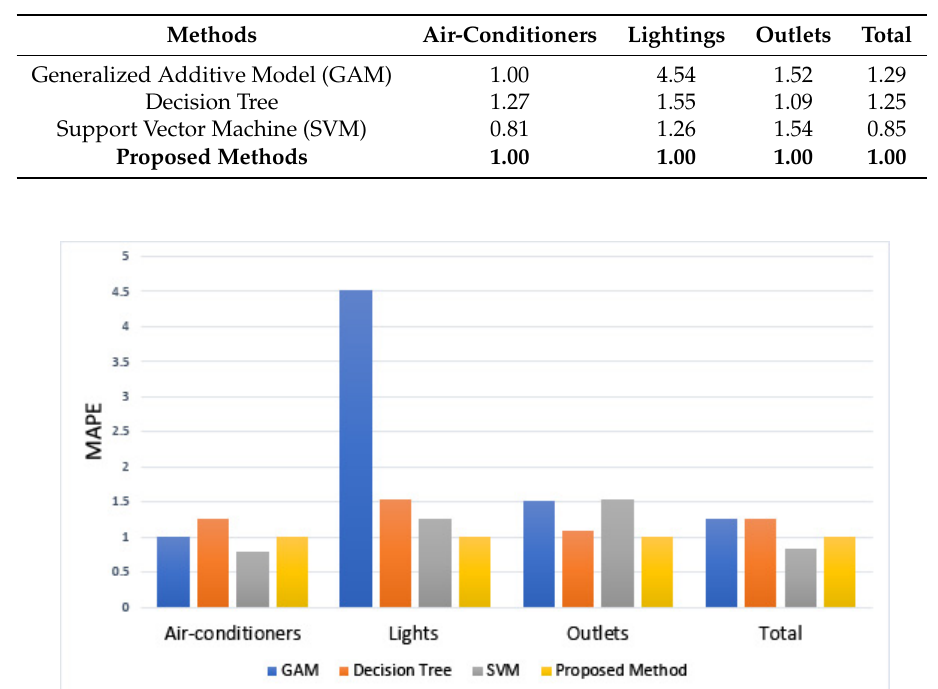
Table 4. Comparison prediction accuracies with other algorithm.